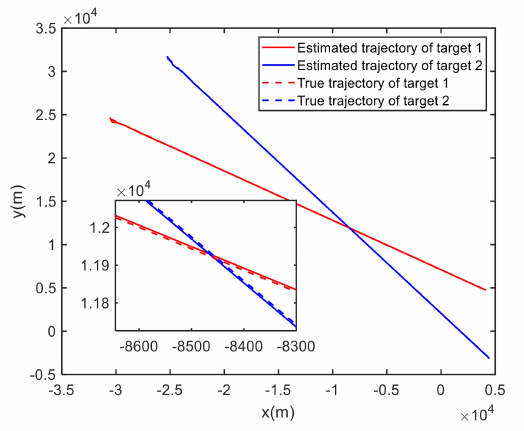
Figure 6. True and estimated tracks using the RL-JPDA in Case 1.